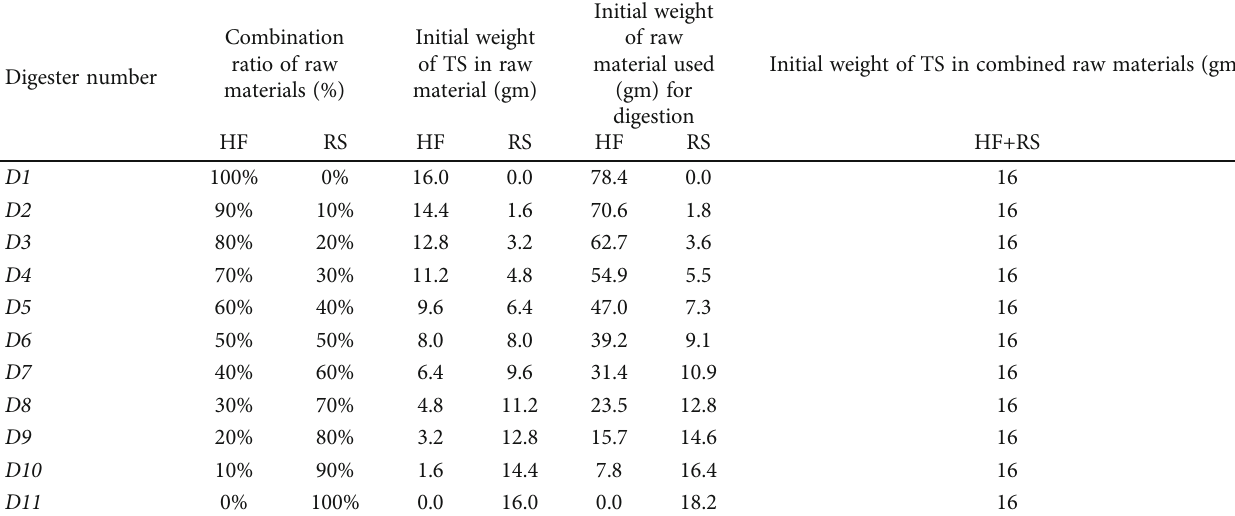
Table 1: Combination of mixtures.